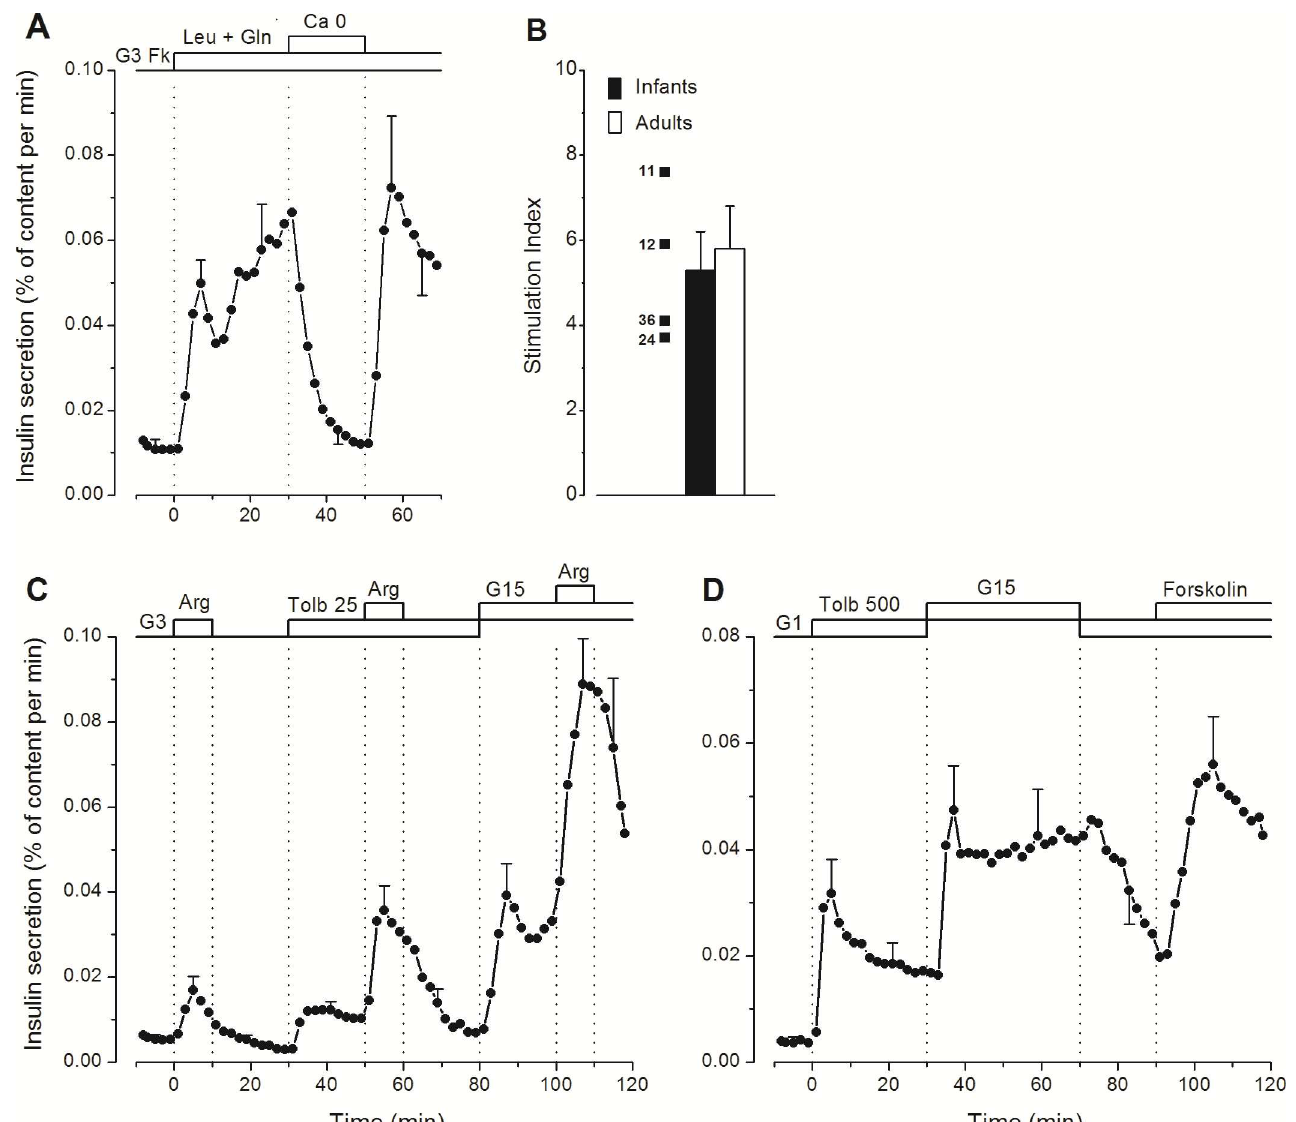
Fig 3. Effects of amino acids and tolbutamide on insulin secretion in perifused islets from human infants. (A) The experiments were done in the presence of 3 mmol/l glucose (G3) and 1 μ mol/l forskolin (Fk) throughout. Leucineand glutamine(5 mmol/l each) were added at 0 min. Between 30 and 50 min, CaCl 2 was omitted and 100 μ mol/l EGTA was added. (B) Insulin secretion induced by leucine + glutaminewas expressed as a stimulation index for the whole response (0–30 min). Mean and individualvalues for islets from four infants (identifiedby age in months) are compared with mean values for 5 islet preparations from normal adults [33]. (C) Three pulses of 10 mmol/l arginine(Arg) were appliedin G3 alone, G3 + 25 μ mol/l tolbutamide (Tolb 25), or G15 + Tolb 25. (D) Islets were fully depolarizedby 500 μ mol/l tolbutamide (Tolb 500) in 1 mmol/l glucose (G1). The glucose concentration was then increasedto 15 mmol/l (G15) between 30 and 70 min, and forskolin (1 μ mol/l) was eventuallyadded to G1 (in 3/5 cases only). Values are means ± SE for islet preparations from 4 (A, B and C) or 5 infants